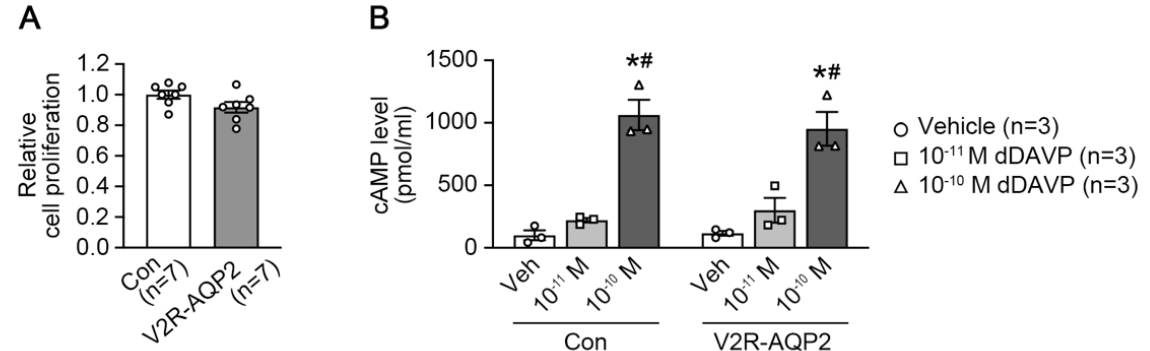
Figure 2. Cell proliferation and dDAVP-induced intracellular cAMP levels in V2R-AQP2 cells. ( A ) Cell proliferation assay (CCK-8) of control mpkCCDc14 cells and V2R-AQP2 cells. n = 7 in each group. ( B ) Intracellular cAMP levels were analyzed in control mpkCCDc14 cells and V2R-AQP2